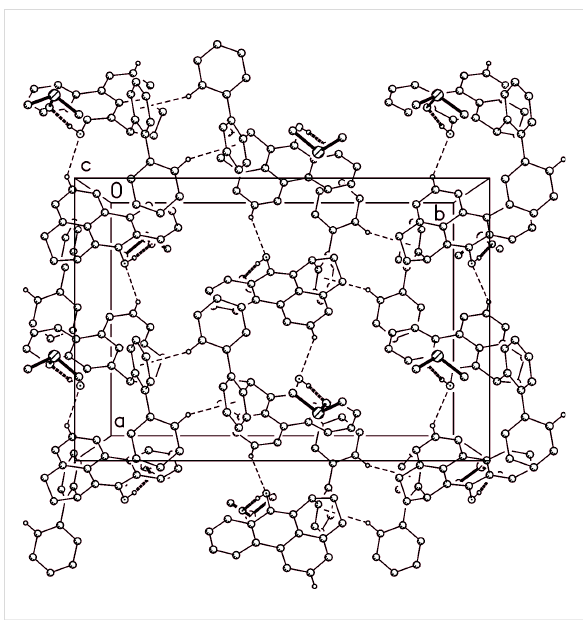
Figure 7: Packing diagram of compound 13 viewed parallel to c ; DMSO molecules (including their hydrogen bonds) are represented by thick bonds. Hydrogen bonds C-H···O and C-H···π are indicated by thin dashed lines. The interactions D99A···π (see text) are omitted for clarity, but their positions are implicit (on the opposite side of the ring from the C-H···π interaction already